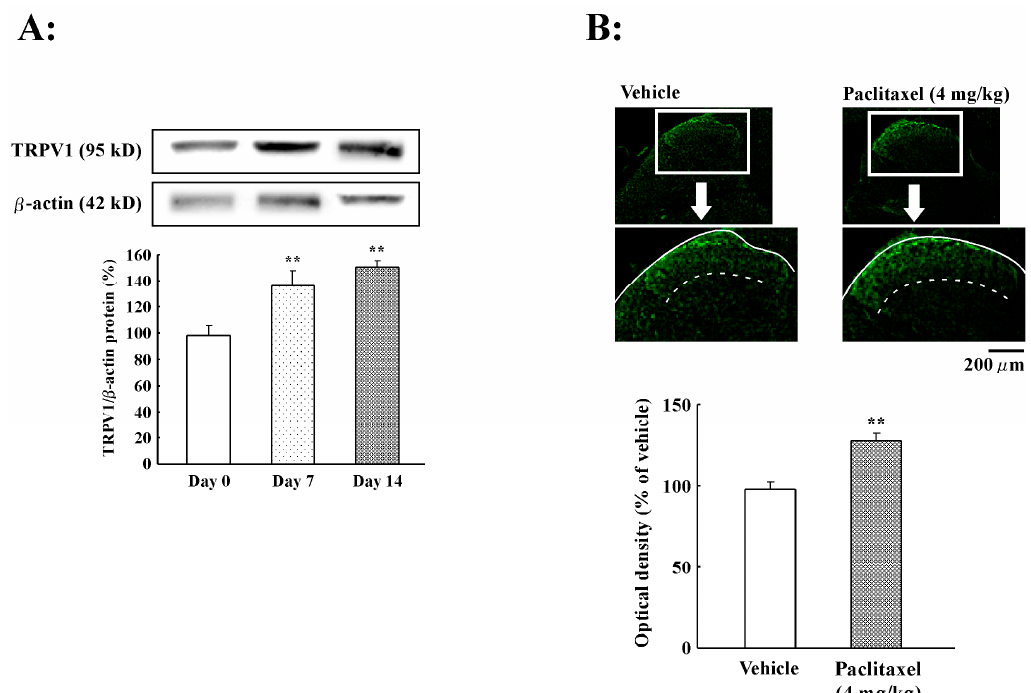
Figure 2. Expression of transient receptor potential vanilloid 1 (TRPV1) protein in rat spinal cord. ( A ) Western blotting analysis of the e ff ect of paclitaxel on TRPV1 protein expression (representative blot shown). TRPV1 protein in the spinal cord at days 0, 7, and 14 after the start of paclitaxel treatment (4 mg / kg) was measured. TRPV1 protein expression was normalized to β -actin expression. Paclitaxel treatment increased TRPV1 protein expression. ( B ) Immunohistopathological analysis of the e ff ect of paclitaxel on TRPV1 protein expression. Paclitaxel (4 mg / kg) induced a significant increase of TRPV1 protein expression. The histogram shows the relative amount of TRPV1 protein in paclitaxel (4 mg / kg)-treated rats. Data are the mean ± SEM of n = 4–5 for the paclitaxel group. ** p < 0.01 versus day 0 or vehicle treatment group.